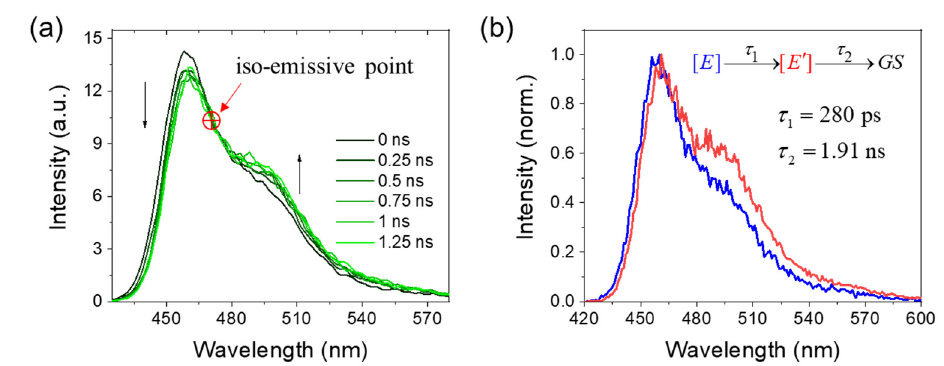
Figure 6. ( a ) Time-resolved area normalized emission spectra (TRANES) of Al 2 O 3 :OHCCA agg at selected times and ( b ) Evolution associated spectra (EAS) obtained from the global analysis. The inset of ( b ) shows the reaction path and associated time constants. A red open circle with a plus sign in ( a ) indicates the iso-emissive point of TRANES.